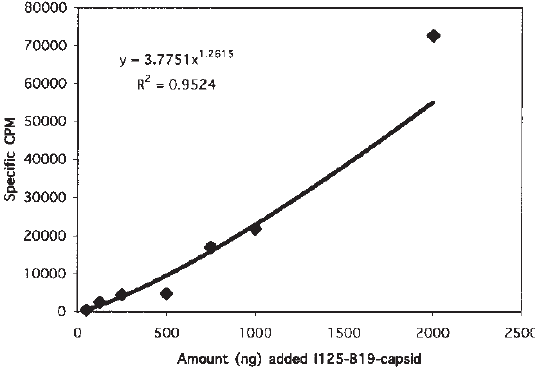
Figure 3 Binding of I 125 -labeled B19 VP2 empty capsid to VTB in vitro . Increasing amounts (50 ng–2 m g) of I 125 - labeled B19 VP2 empty capsid were added to 2.5 6 10 5 VTB per reaction. Cell-specific binding was defined as total counts per minute (cpm) less the non-specific cpm present in the no-cell control. Data points were analyzed by linear regression and the correlation coefficient (R 2 = 0.9524) was calculated